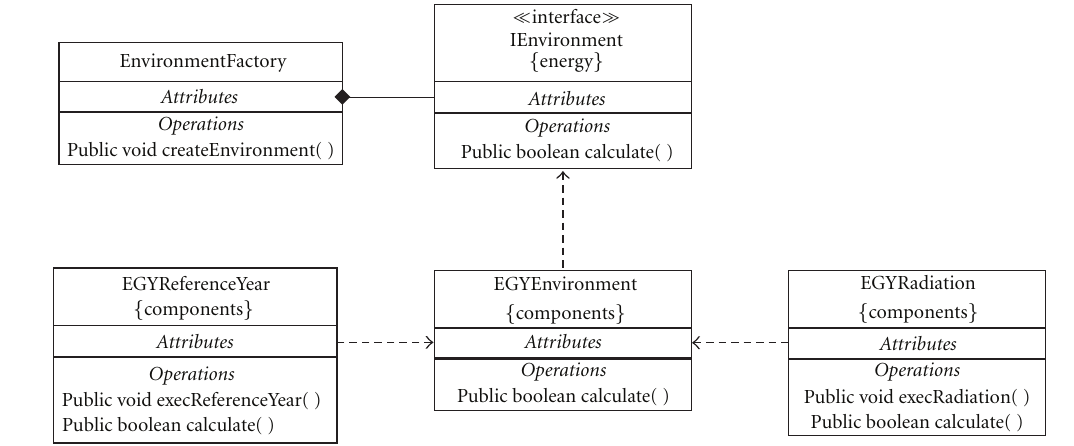
Figure 2: The class diagram and the factory pattern implementation.